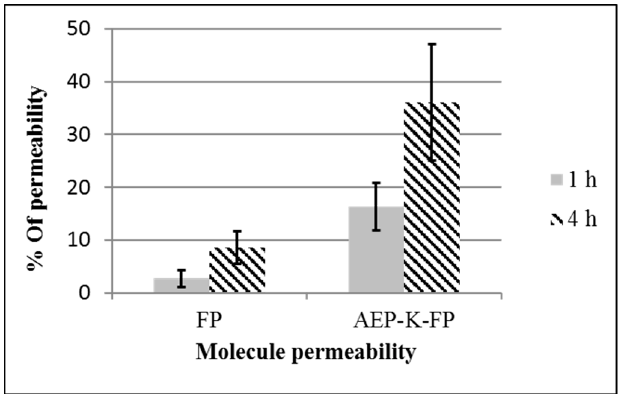
Figure 6. The high performance liquid chromatography (HPLC) analysis and corresponding standard curve of FP and AEP-K-FP.